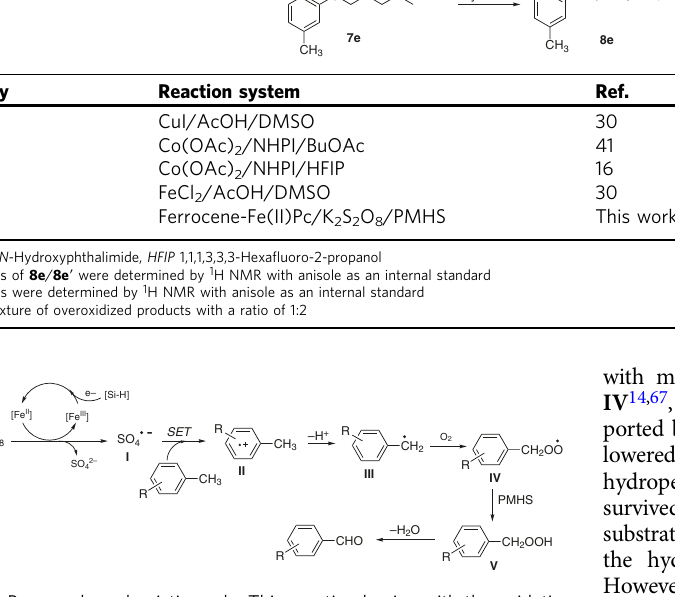
Fig. 5 Proposed mechanistic cycle. This reaction begins with the oxidation of Fe(II) by persulfate to generate the Fe(III) species and the sulfate radical anion I 58 that reacts with alkylarene by single electron transfer (SET) to produce the alkylaromatic radical cation II 59 – 61 . Inter-